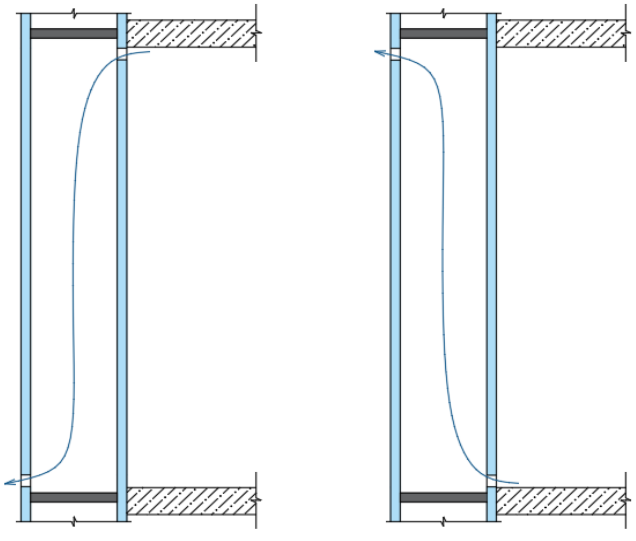
Figure 12. Facade systems with exhaust mode.